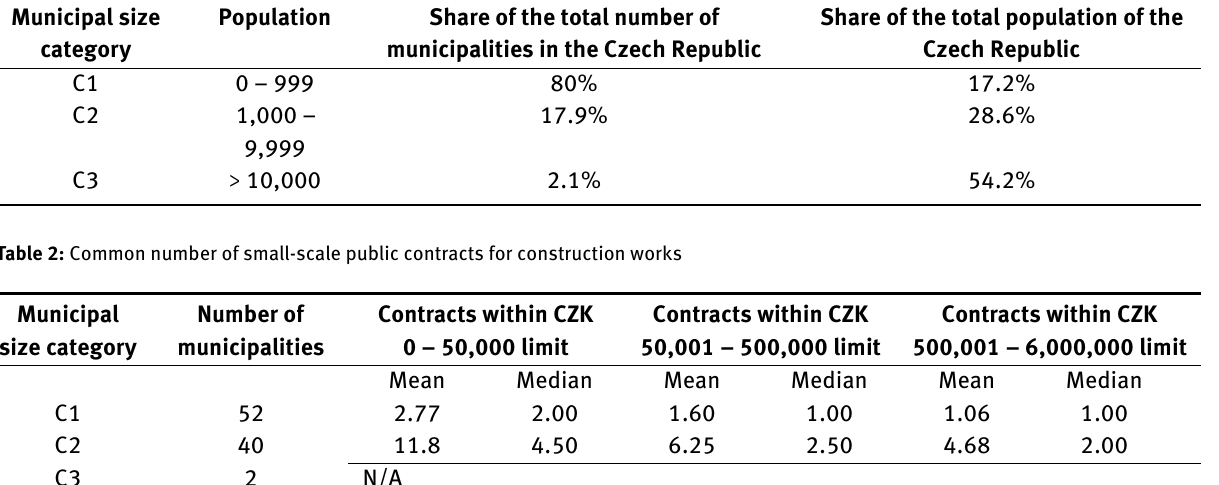
Table 1: Municipal categories based on population [15] (Czech Statistical Oflce, 2001) Municipal size category